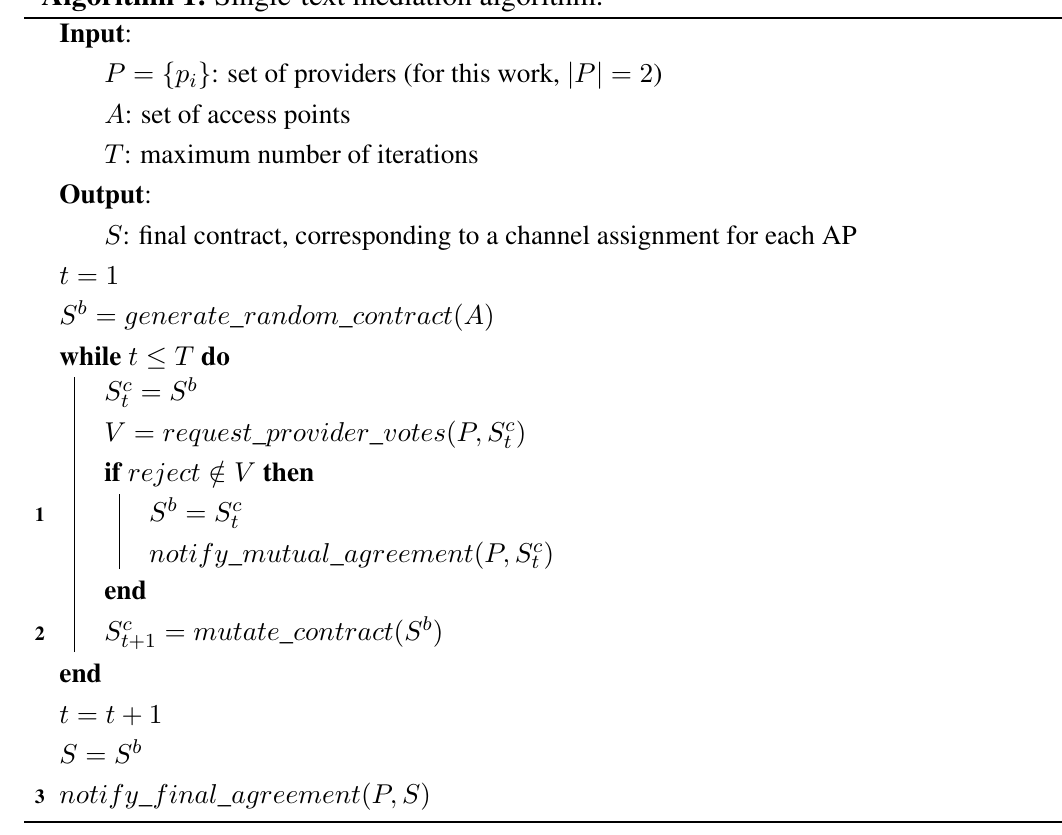
Algorithm 1: Single-text mediation algorithm.